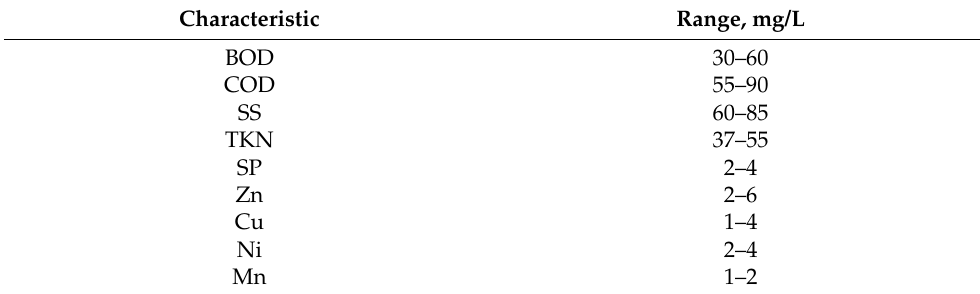
Table 2. Characteristics of the partly treated sewage which was fed to SHEFROL.